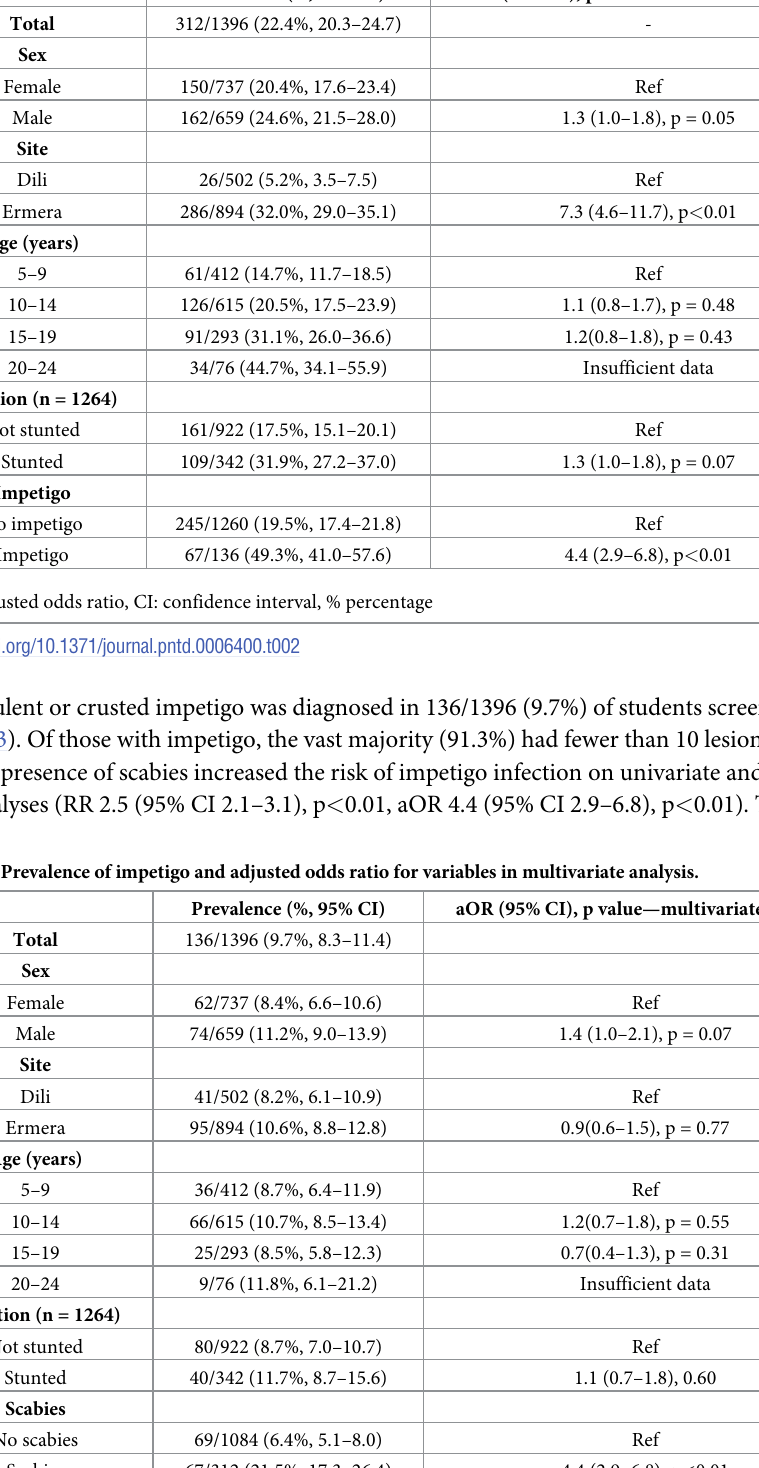
aOR: adjusted odds ratio, % percentage, 95% CI: 95% confidence